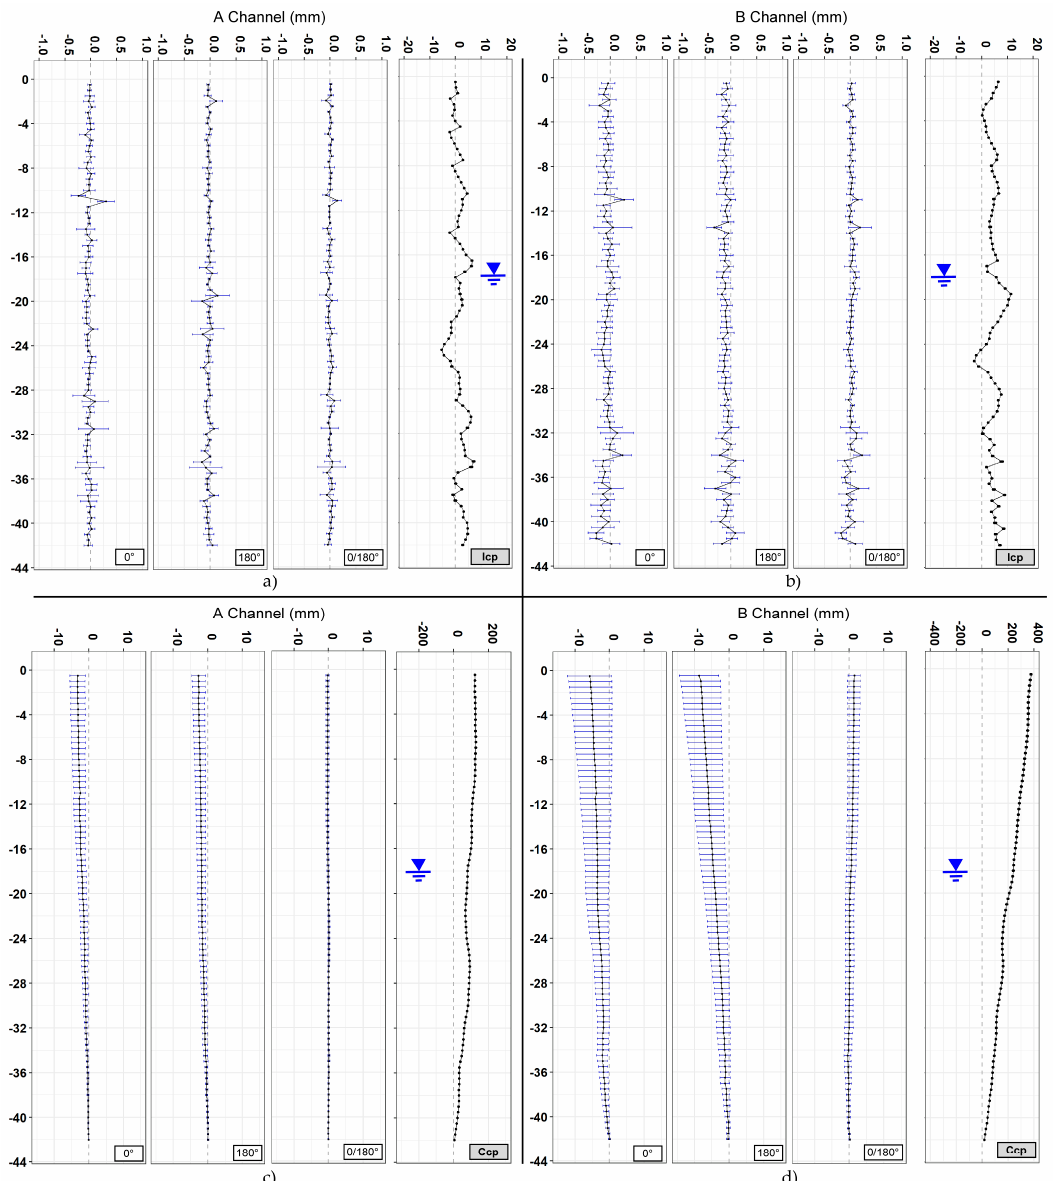
Figure 11. Section 3. ( a ) Incremental displacements for the A channel; ( b ) incremental displacements